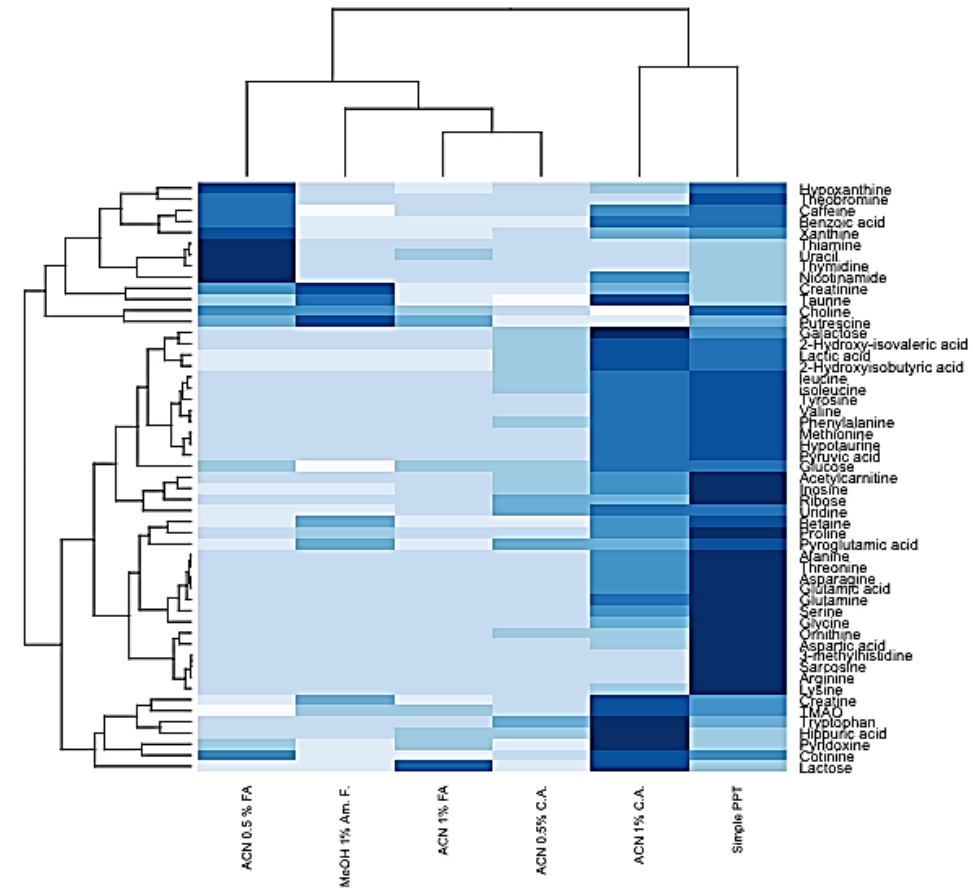
Figure 3. Pearson correlation heat-map indicating the response of the detected metabolites under PPT treatment and different HybridSPE conditions. Colour coding: signal response (peak area) increases from light to dark blue. Hierarchical clustering shows metabolites with similar trends with the applied